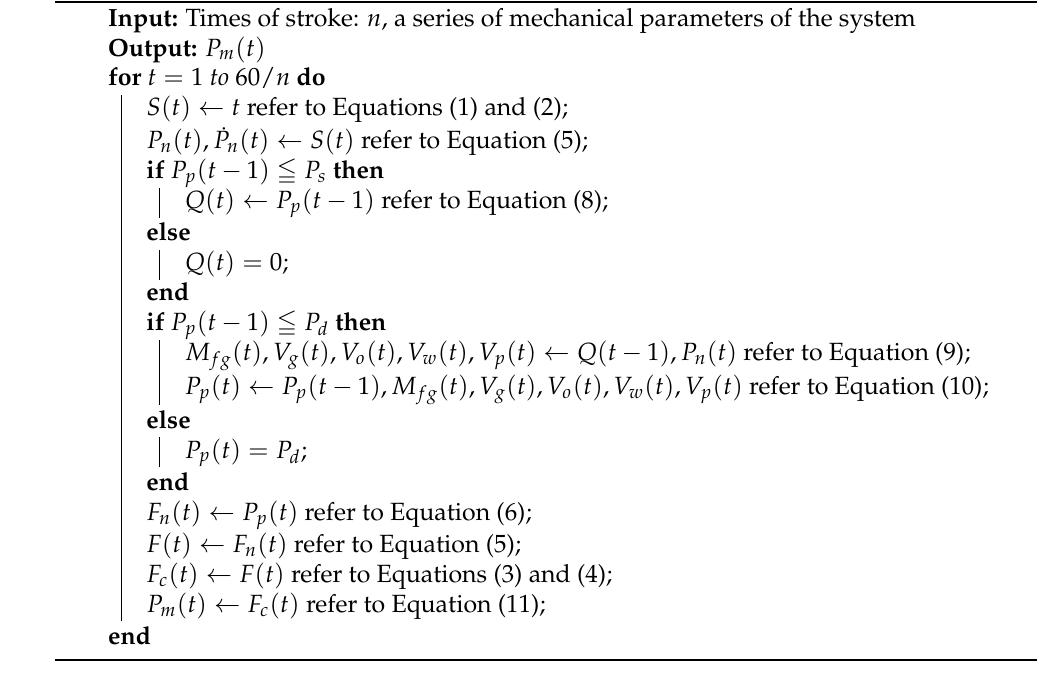
Algorithm 1: Generation of motor power